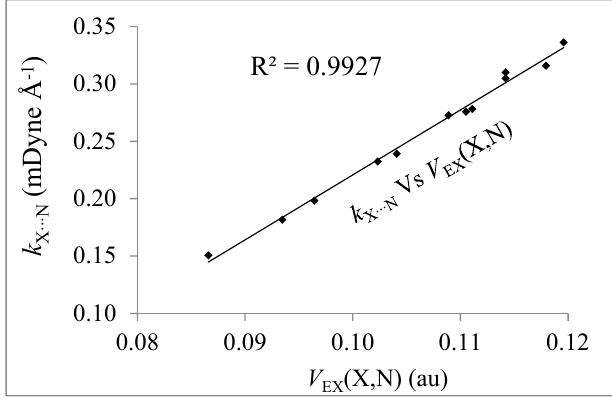
Figure 4. Relationships between V EX (X,N) and k X ∙∙∙ N .